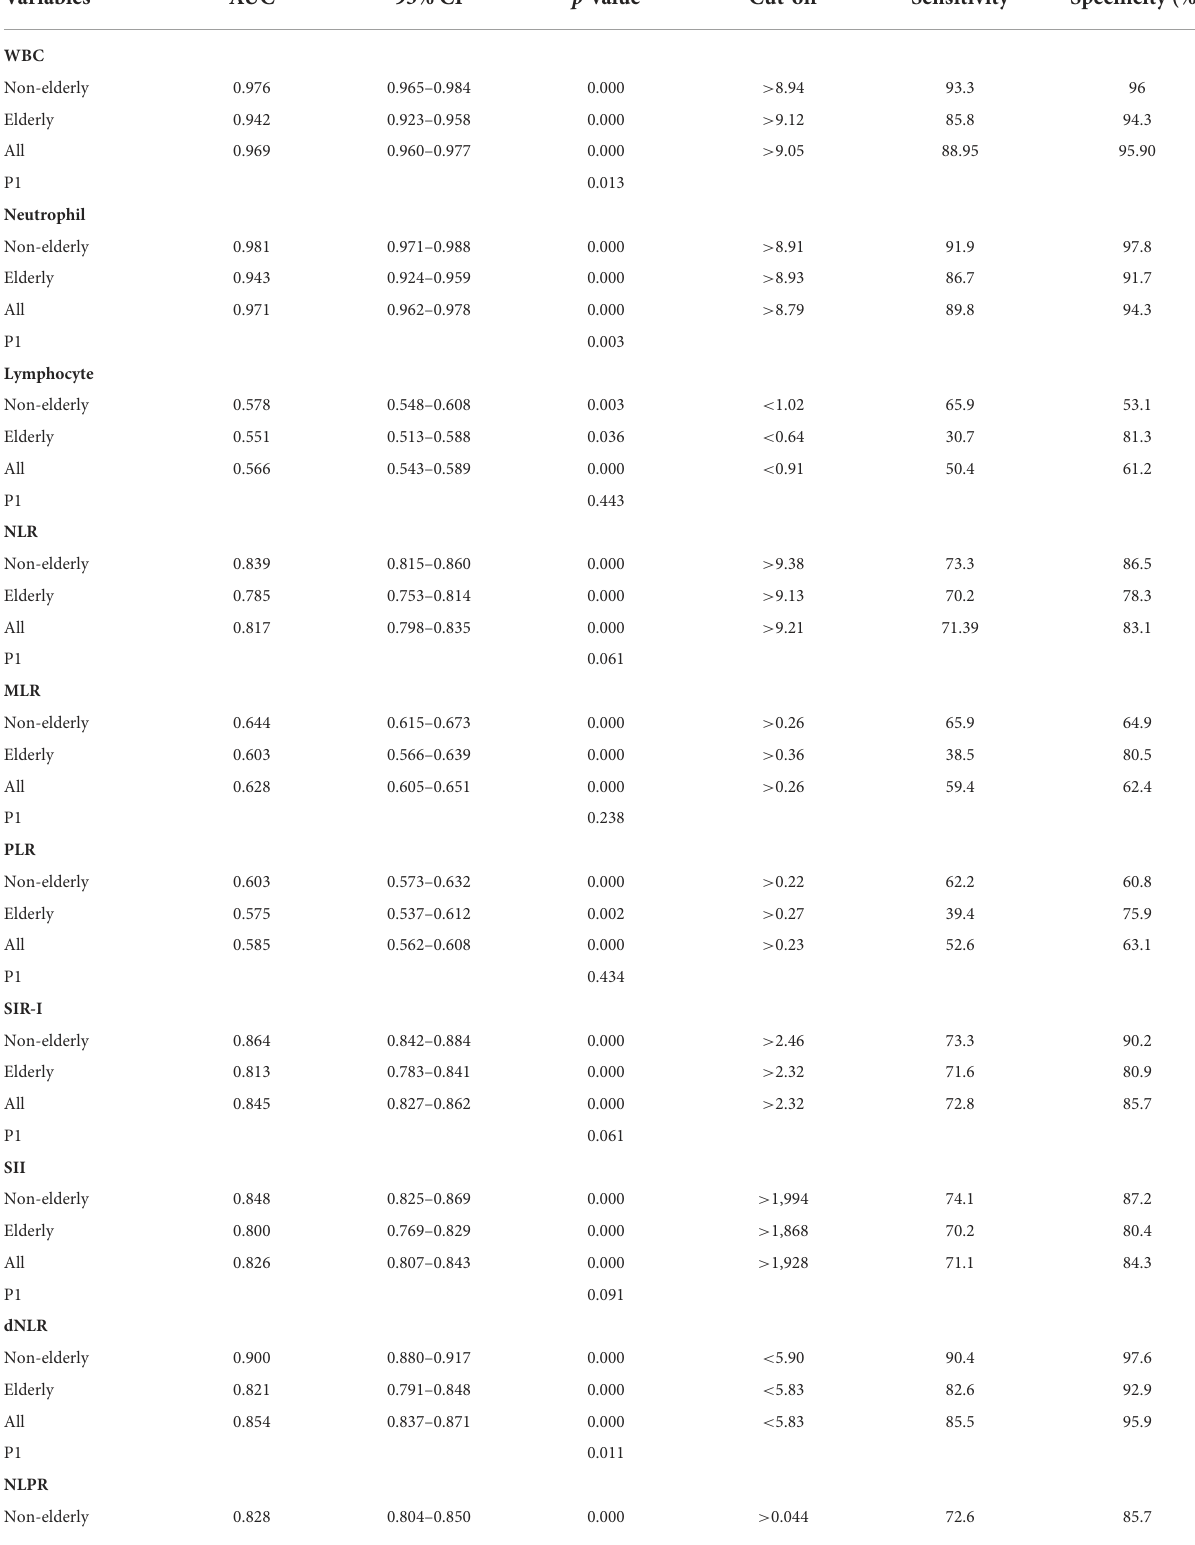
TABLE 3 Receiver operating characteristics (ROC) curves and prognostic accuracy of blood cell count-derived inflammation indexes in non-elderly and elderly COVID-19. Variables